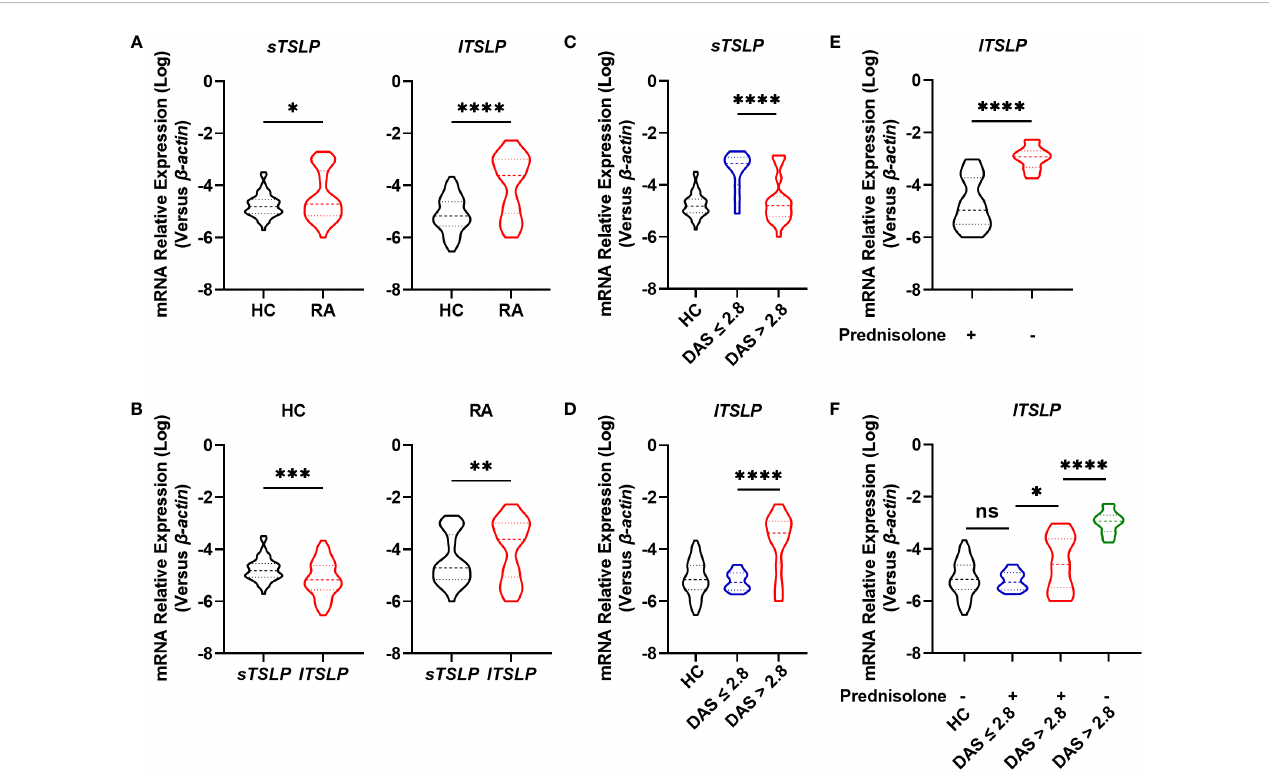
FIGURE 1 Comparison of mRNA levels of TSLP isoforms between RA patients and HC. (A) RT-qPCR analysis of the mRNA expression of sTSLP and lTSLP in PBMCs from RA patients (n = 68) versus HC (n = 66). (B) RT-qPCR comparison of sTSLP and lTSLP mRNA expression in PBMCs from HC and RA patients. (C, D) RT-qPCR analysis of sTSLP and lTSLP mRNA levels in active and inactive RA patients was compared to HC. (E) RT-qPCR analysis of the mRNA expression of lTSLP in RA patients with or without prednisolone treatment. (F) RT-qPCR analysis of lTSLP mRNA expression in HC and in active and inactive RA patients following prednisolone treatment. Data are depicted as a violin plot. (A-F) were analyzed by unpaired two-tailed Student ’ s t-test. *P < 0.05, **P < 0.01, ***P < 0.001, and ****P < 0.0001. ns, no signi fi